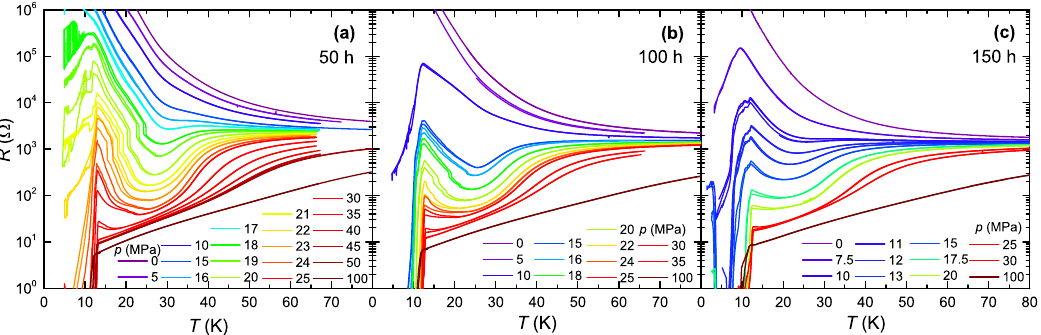
Figure 5. Out-of-plane resistance R of κ -(BEDT-TTF) 2 Cu[N(CN) 2 ]Cl (crystal #5-7), which was exposed to X-ray irradiation for 50h ( a ); 100h ( b ) and 150h ( c ), as a function of temperature T at various constant pressure values 0MPa ≤ p ≤ 100MPa upon warming and upon